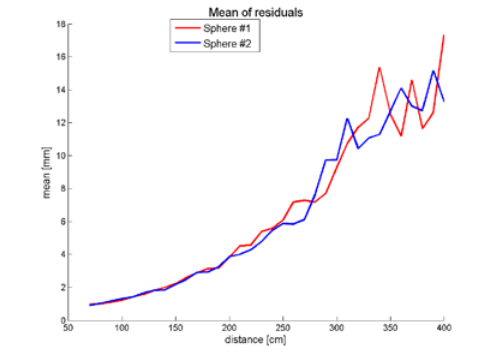
Figure 13. Key points (red) locations on a human face (Varga et al. ,